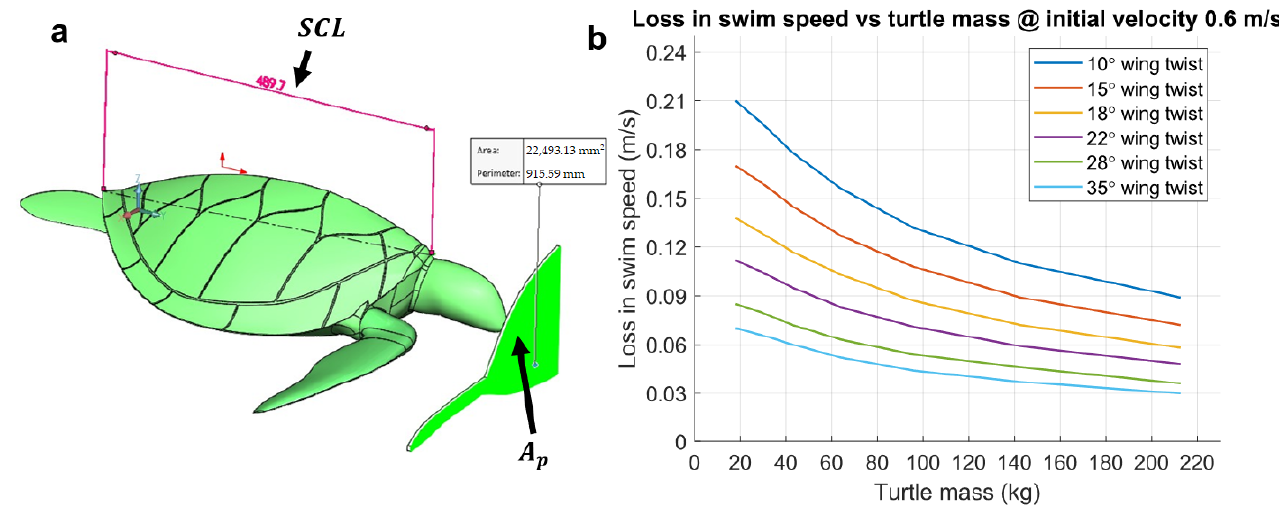
Figure 9. Turtle geometry and its effects on swim speed. ( a ) Extraction of turtle frontal area 𝐴 𝑝 with respect to S.C.L. from CAD. ( b ) Loss in turtle swim speed during a passive upstroke with an initial swim speed of 0.6 m/s versus turtle mass. Based on the time required for each wing to complete upstroke displacement of 79.6° obtained from testing data.